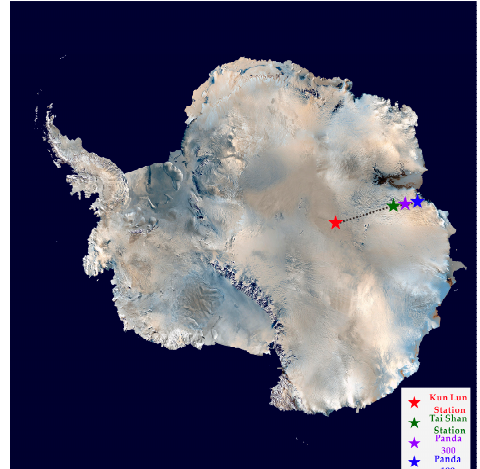
Figure 1. Position distribution of the four